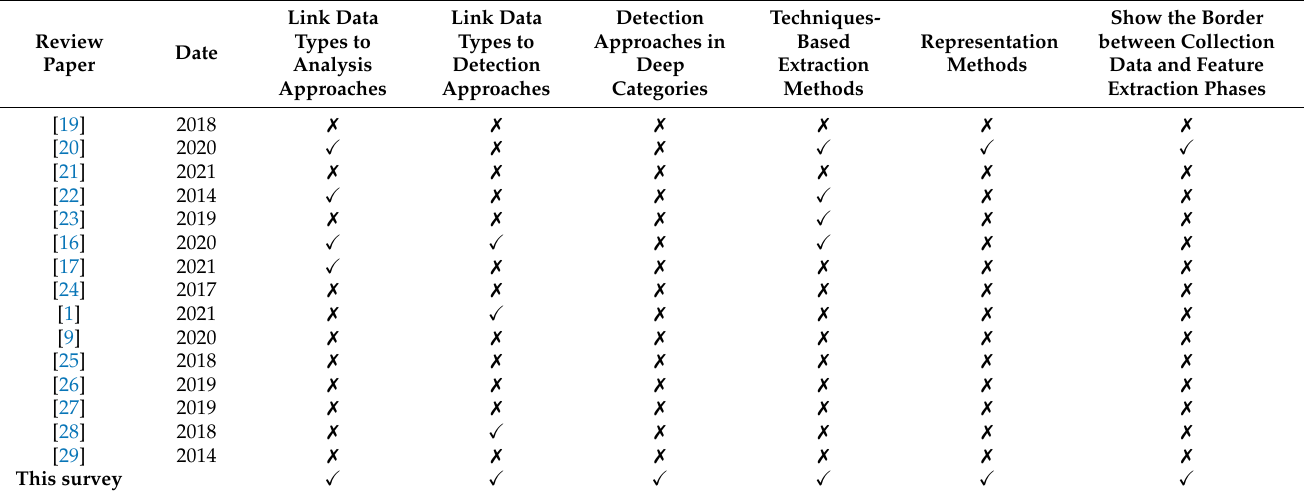
Table 1. A list of the contributions to this survey with a comparison to the previous review papers.